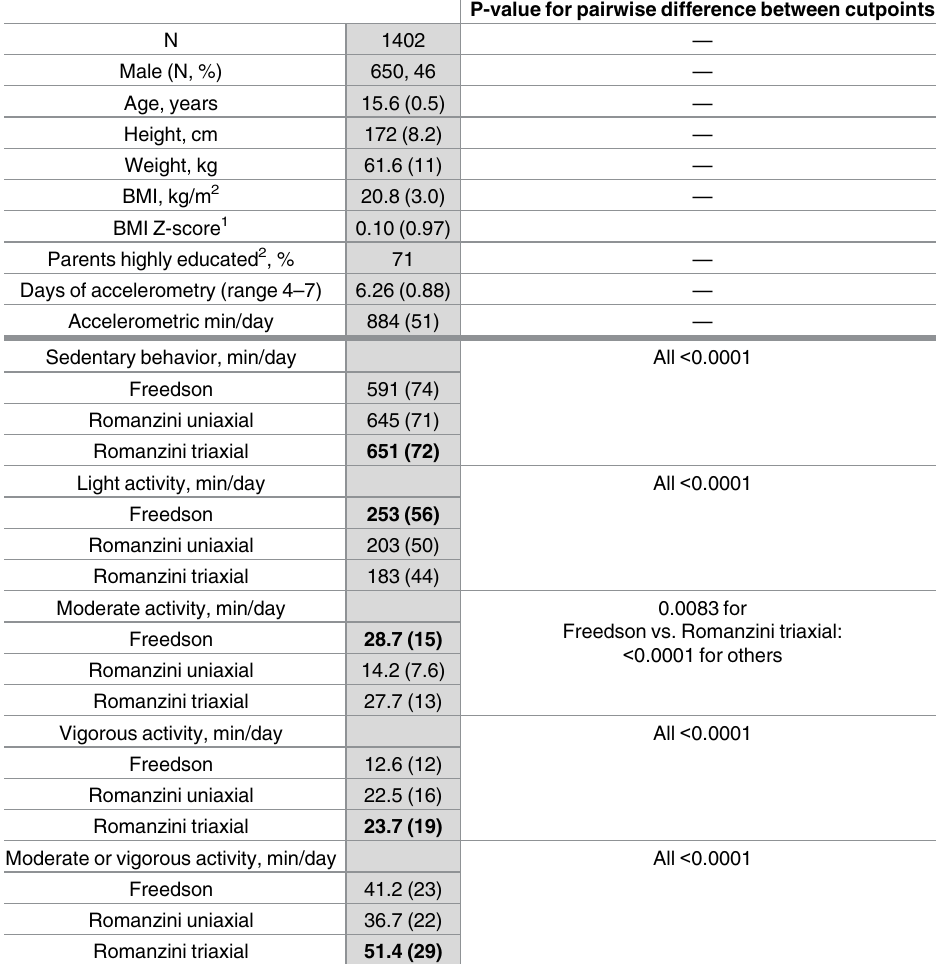
Table 1. Population characteristics. Mean (standard deviation)unless otherwisestated. P-value for pairwise difference between